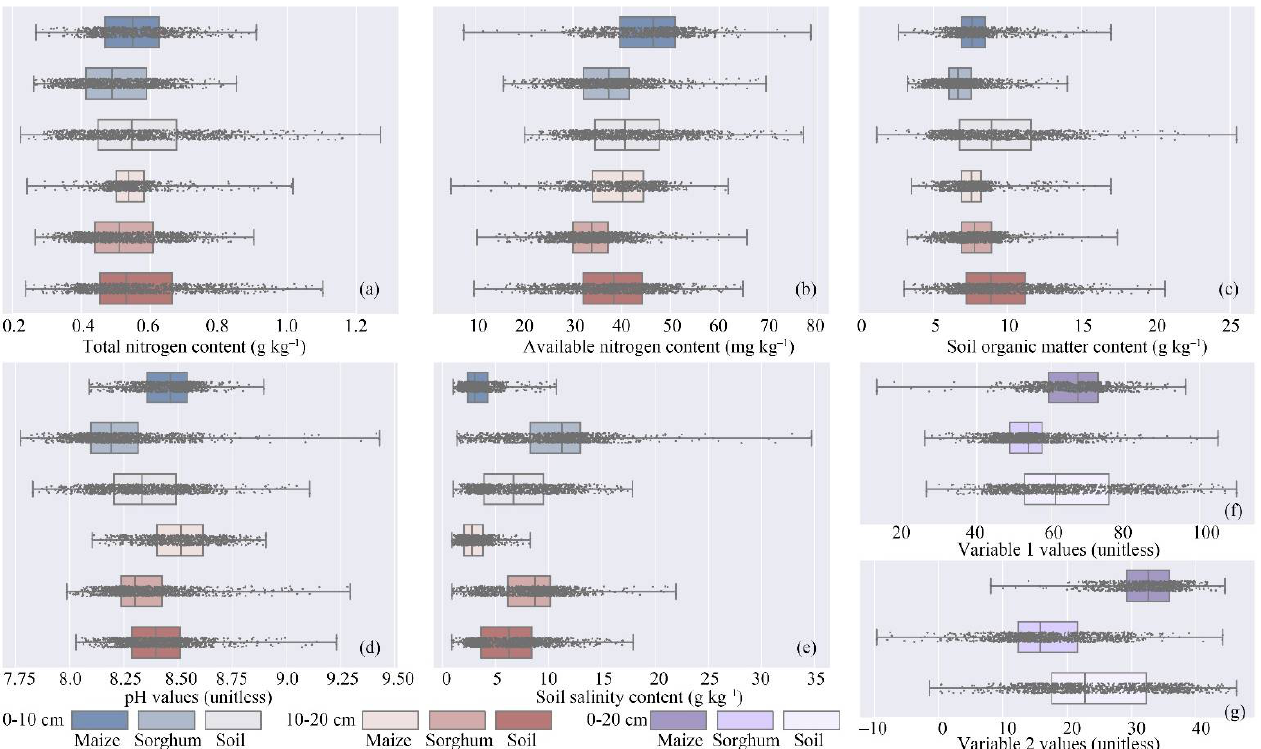
Figure 5. Soil attributes/latent variables at the bare soil, maize-, and sorghum-cultivated regions: ( a ) total nitrogen content (g kg −1 ); ( b ) available nitrogen content (mg kg −1 ); ( c ) soil organic matter content (g kg −1 ); ( d ) pH values; ( e ) salinity content (g kg −1 ); ( f ) Variable 1 values (unitless); and ( g ) Variable 2 values (unitless, see Section 2.4.2).